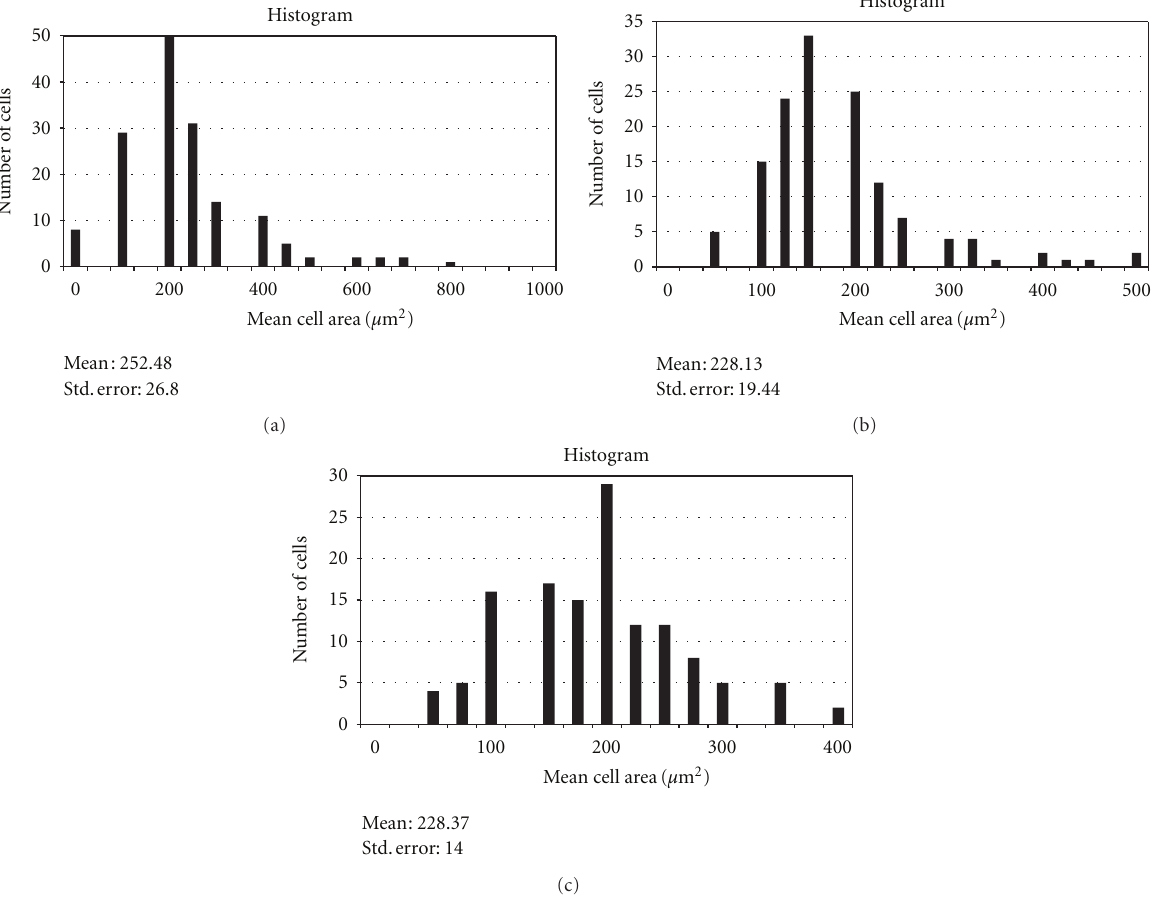
Figure 3: (a) Mean cell areas for in vivo primary root cells. (b) Mean cell areas for in vitro primary root cells (normal). (c) Mean cell areas for in vitro primary root cells